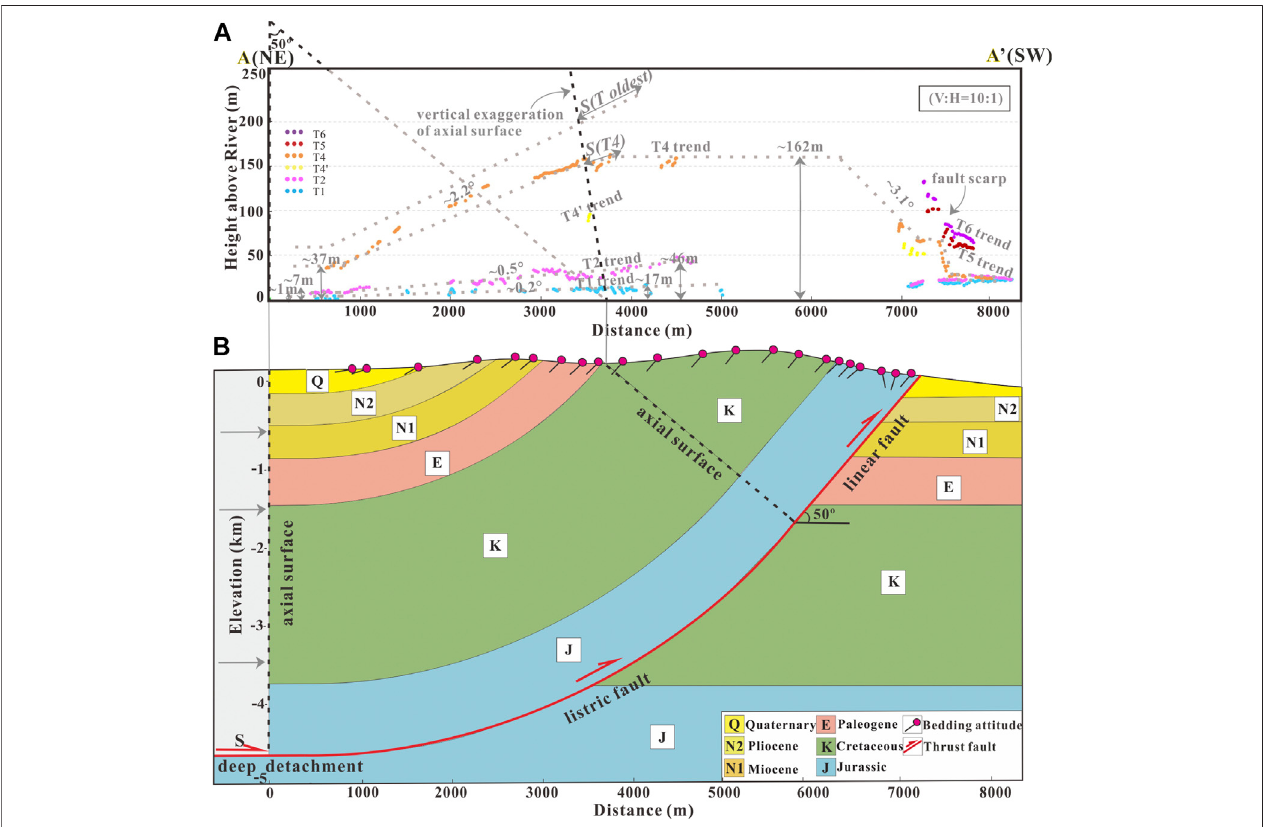
FIGURE 7 | According to the terrace deformation pattern and bedding attitudes, we use the combined fault folding model (see Figure 6C for detailed information) to reconstruct the kinematic relationship between the deformed river terraces and the subsurface fault geometry. (A) Terrace deformation pattern of the Tuyugou Valley (see Figure 3C for the location of A-A ’ ). (B) Subsurface fault geometry at the Tuyugou Valley, which is inferred from the terrace deformation pattern, bedding attitudes and the combined fault folding